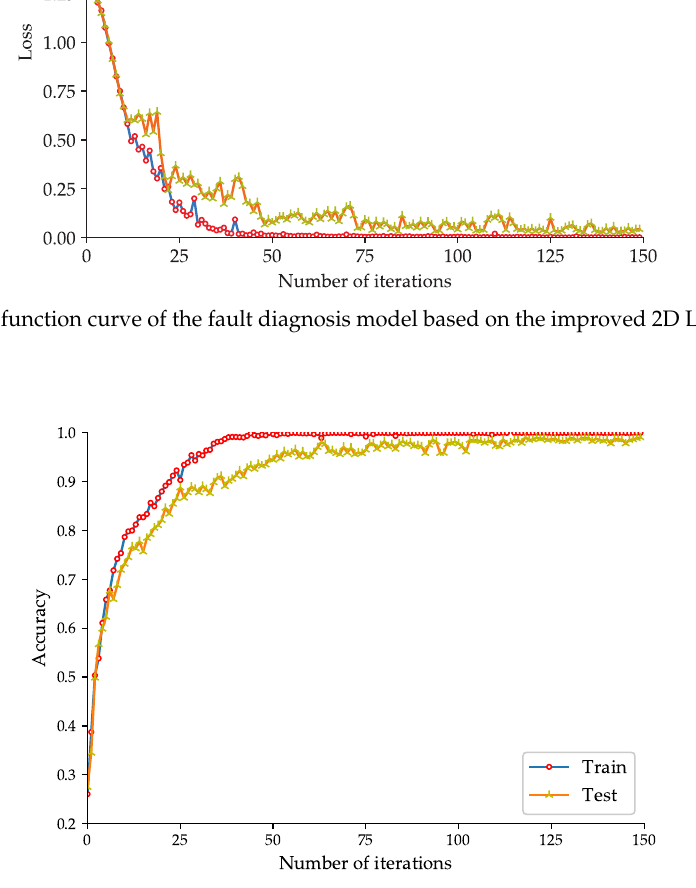
Figure 7. Accuracy curve of the fault diagnosis model based on the improved 1D LeNet-5 network.